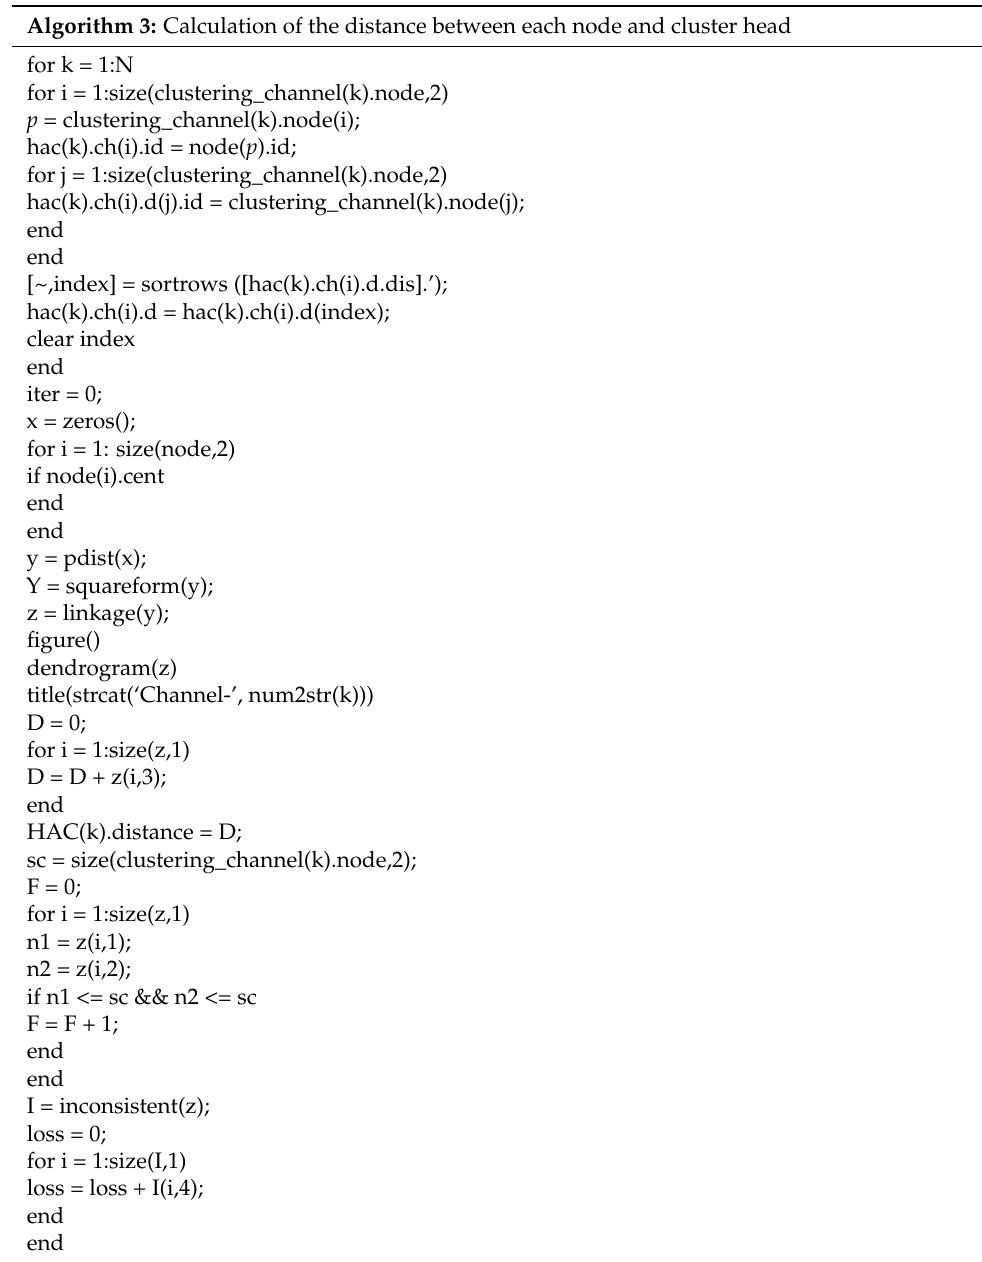
Table 4. Calculation of the distance between each node and cluster head. Algorithm 3: Calculation of the distance between each node and cluster